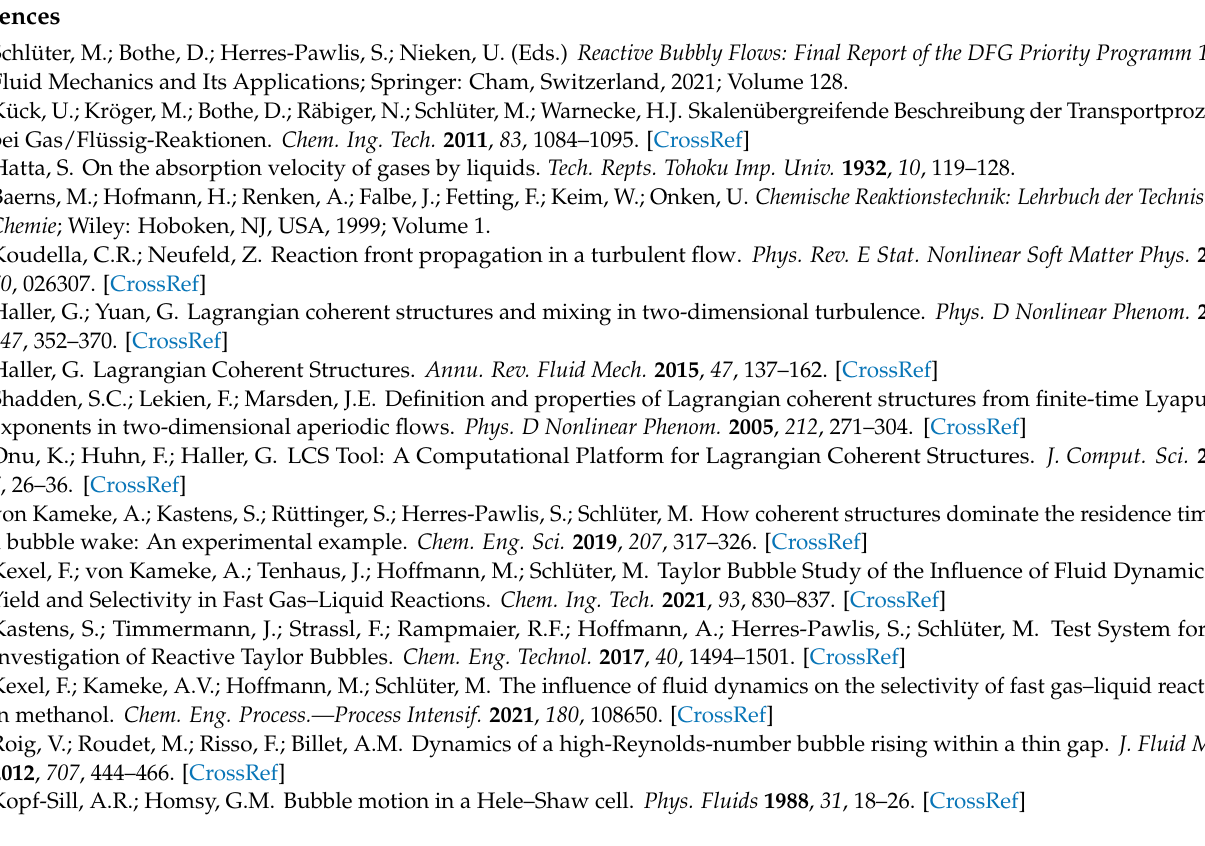
Figure S3: Unprocessed velocity field for the case of the ellipsoidal bubble; Figure S4: Smoothed velocity field for the case of the ellipsoidal bubble; Figure S5: Concentration field in the wake of the wobbling bubble for t = 3 s; Figure S6: Concentration field in the wake of the ellipsoidal bubble for t = 3 s; Table S1: Parameters used for the PIV image analysis in PIVview 2c V3.62 ( PIVTEC GmbH ,